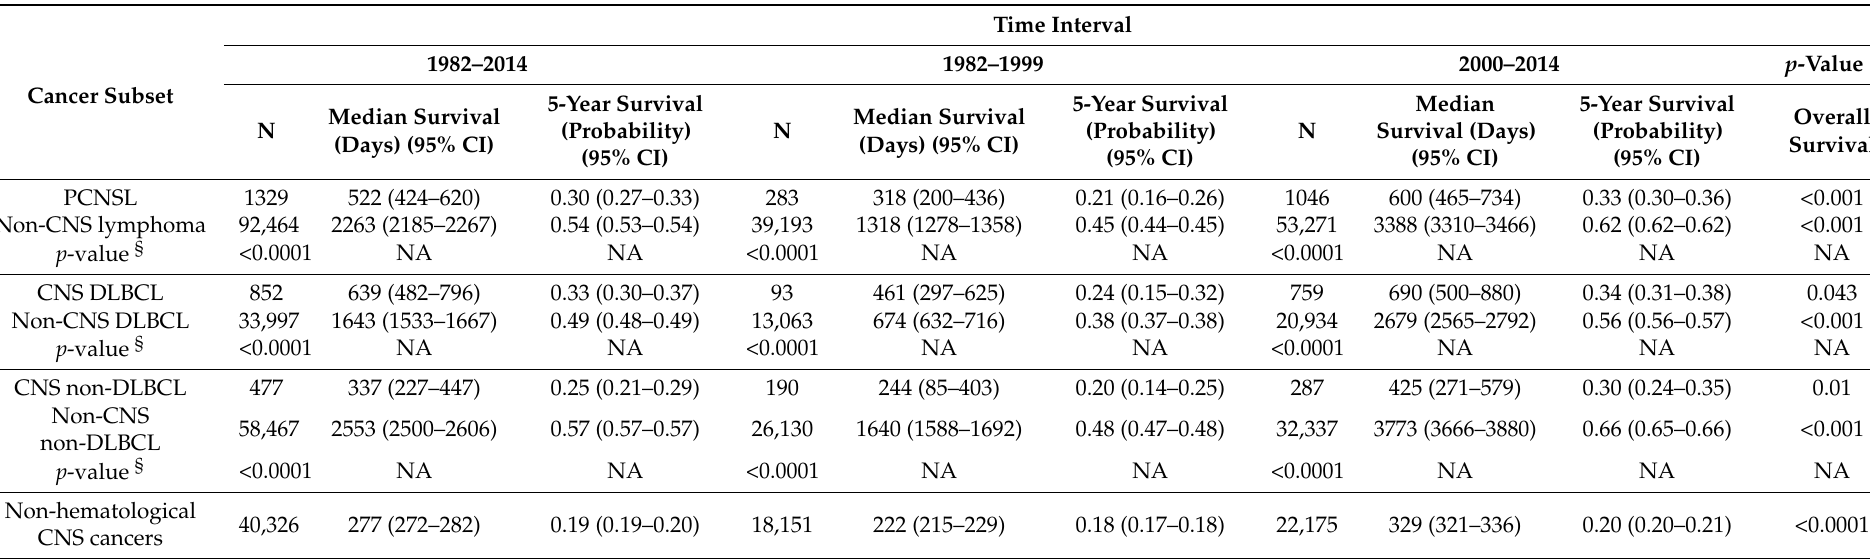
Table 4. Survival outcomes for CNS and non-CNS lymphomas, and non-hematological CNS cancers in Australian adults between 1982 and